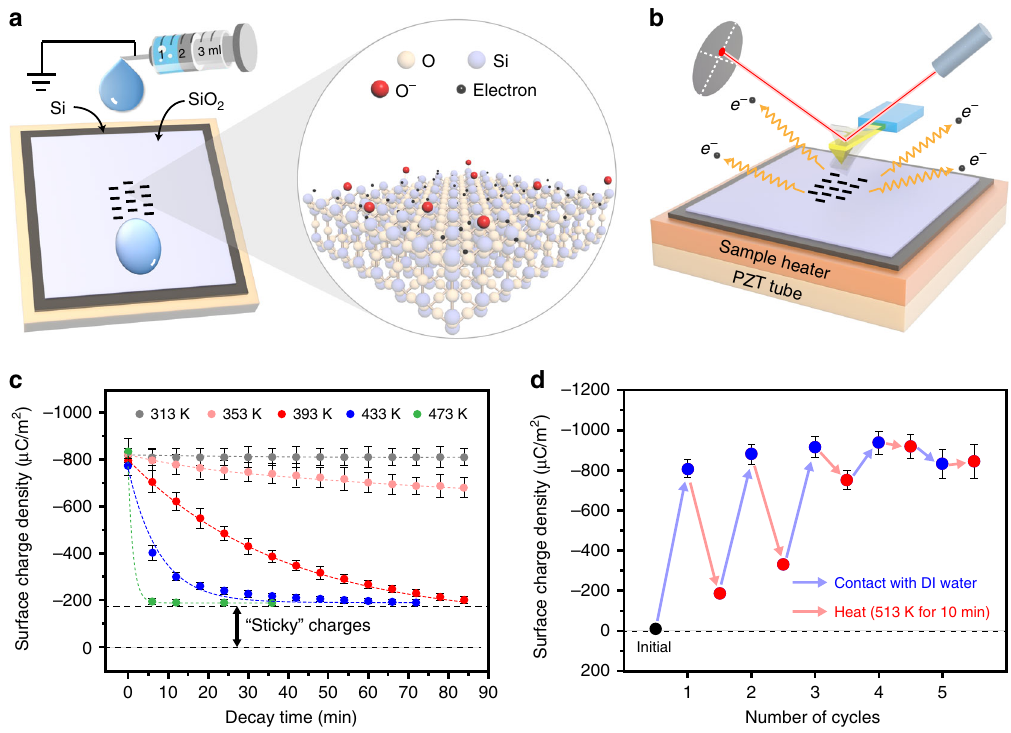
Fig. 1 Temperature effect on the CE between the DI water and the SiO 2 . ( a ) The setup of the charging experiments, where the negative charges generated on the SiO 2 surface could be electrons and O − ions induced by surface ionization reaction. ( ‘ O ’ is the Oxygen atom, ‘ Si ’ is the silicon atom and ‘ O − ’ is the Oxygen ion). ( b ) The setup of AFM platform for the thermionic emission experiments. ( c ) The decay of the CE charge (induced by contacting with the DI water at room temperature) on the SiO 2 surface at different substrate temperatures. ( d ) The CE charge density on the SiO 2 sample surface in the charging (contacting with the DI water at room temperature) and heating (at 513 K for 10 min) cycle tests. (Error bar are de fi ned as s.